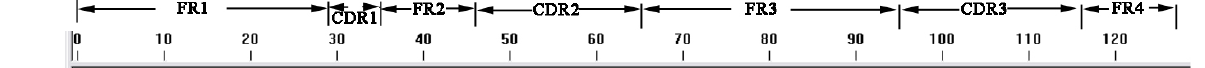
Figure 1. Comparative alignment of the amino acid sequences of anti-BAFF (B cell-activating factor) sdAbs, showing four hallmark amino acid changes at positions F(Y) 37, E44, R45 and G47. The cysteine positions in complementarity-determining region 1 (CDR1) and CDR2 are fixed at between 31–35 and 45–67, respectively. The position of cysteine in CDR3